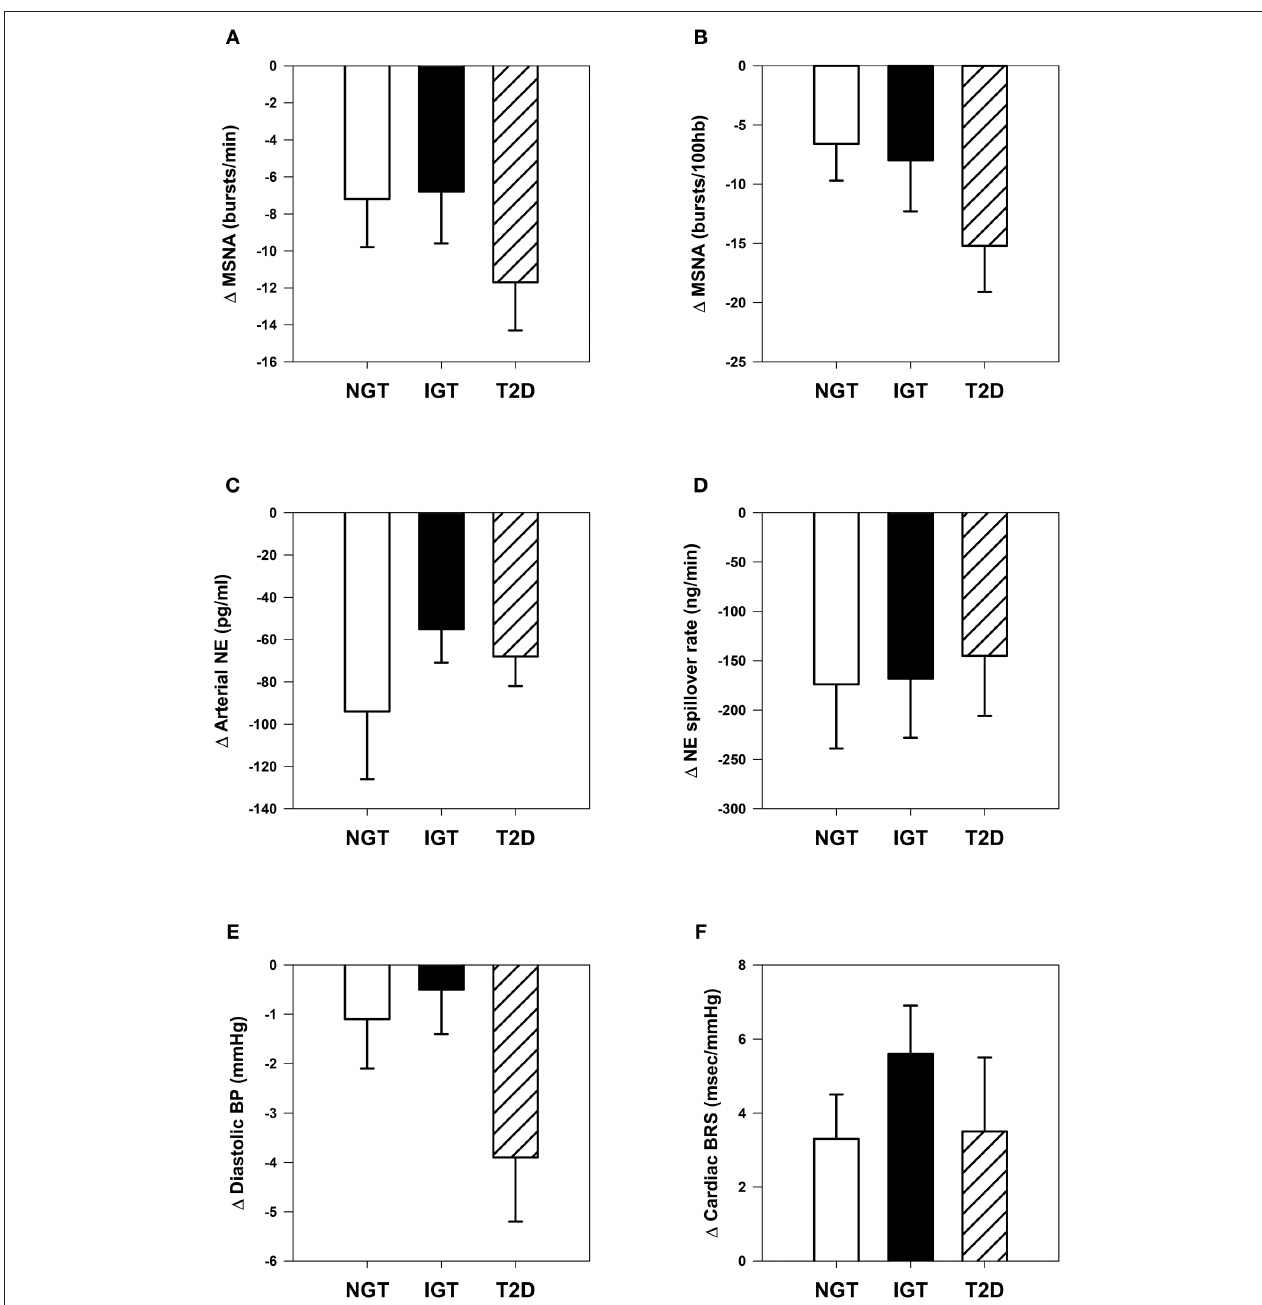
FIGURE 2 | Comparative changes in sympathetic neural and cardiovascular parameters. (A) Muscle sympathetic nerve activity (MSNA) expressed as burst frequency: time effect, P < 0.001. (B) MSNA expressed as burst incidence: time effect, P < 0.001. (C) Arterial norepinephrine (NE) concentration: time effect, P < 0.001. (D) Whole-body NE spillover rate: time effect, P < 0.001. (E) Clinic diastolic blood pressure (BP): time effect, P = 0.005; time × group interaction, P = 0.09. (F) Spontaneous cardiac baroreflex sensitivity (BRS): time effect, P <